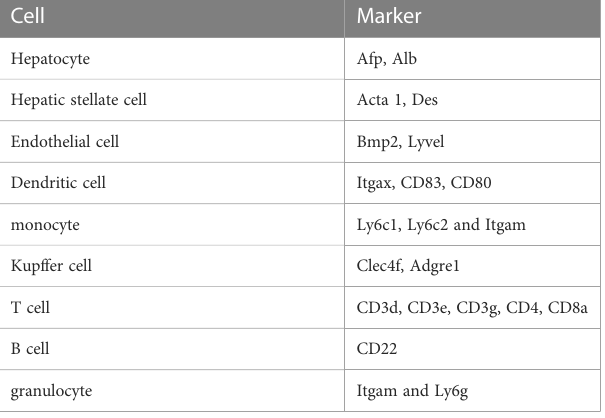
TABLE 1 The representative markers of liver cells for single cell analysis. Cell Marker